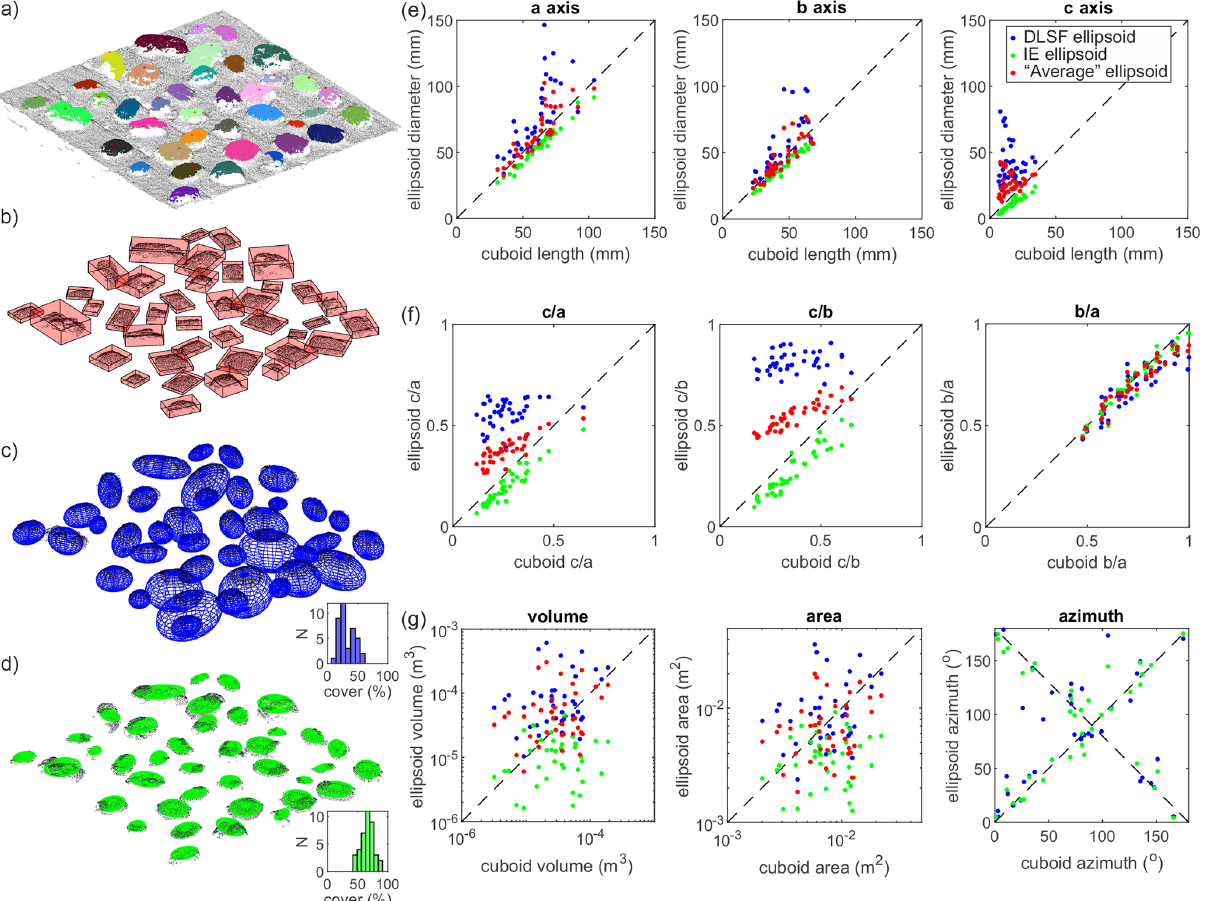
Figure 5. Results from the lab experiment considering 39 pebbles on a flat surface. (a) Point cloud (gray dots) of the experiment overlaid by the label (color) of each identified grain and their summit node (red dot). The resulting (b) cuboid (red) and ellipsoids obtained with (c) a direct least square (DLSF, blue) and (d) the inertia ellipsoid (IR, green) approaches. Diameters measured along the (e) a axis (left), b axis (center) and c axis (right) using the direct least square (DLSF, blue dots) and the inertia ellipsoid (IE, green dots) approaches for the 39 grains as a function of the cuboid lengths (see Fig. S4). The red dots show the dimensions of the average ellipsoid between the IE and DLSF ellipsoids. (f) Axis ratios of the ellipsoids as a function of the axis ratios of the cuboids. (g) Volume, area and azimuthal angle of the a axis (0–180 ◦ ) of the ellipsoids as a function of the azimuthal angle of the cuboids. The black dashed lines show the 1 : 1 line on all the